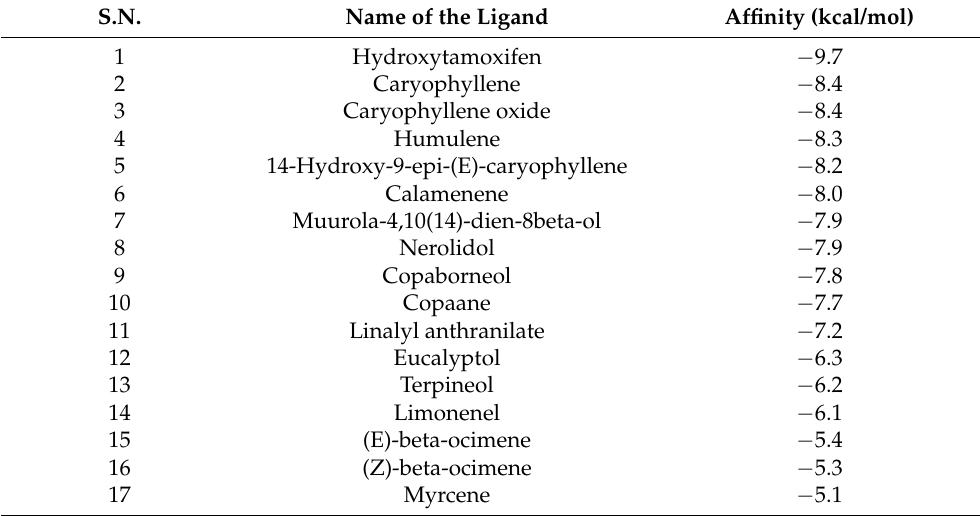
Table 3. Table showing the binding affinity of all the compounds used in docking.